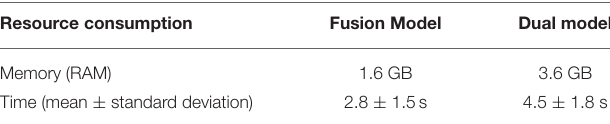
TABLE 3 | The data of memory usage and execution time for the fusion and the dual models to process one image of the private testing